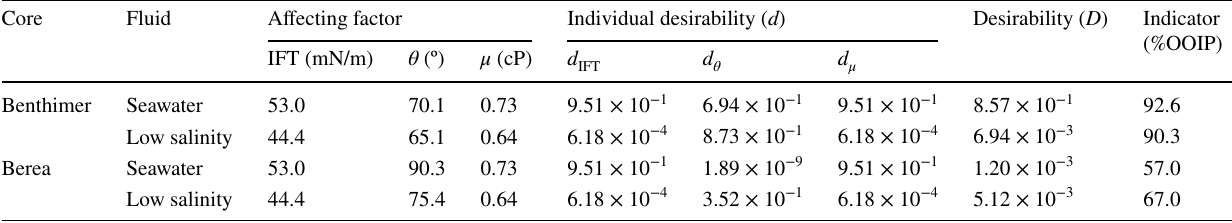
d θ and d μ ) and com- IFT ,